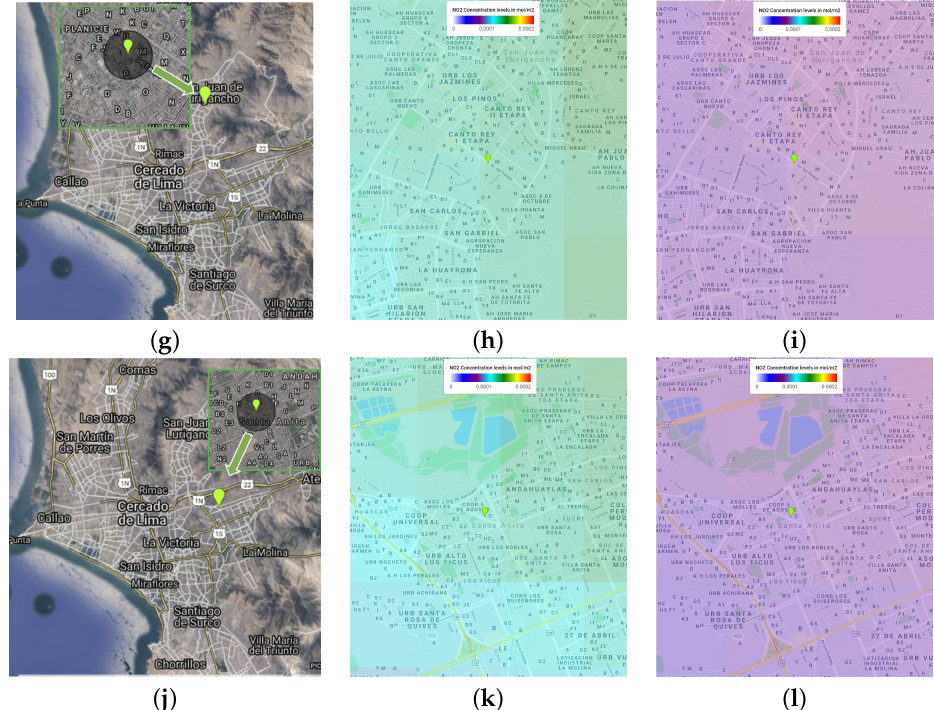
Figure 3. Example of spatial georeference for four areas of interest used to better understand the concentration levels of NO 2 around the region of interest. ( a ) Location of the sensor in Carabayllo and the visual comparison for ( b ) January–June 2019 and ( c ) January–June 2020. ( d ) Location of the sensor in the US embassy in Peru, and the visual comparison for ( e ) January–June 2019 and ( f ) January– June 2020. ( g ) Location of the sensor in ‘San Juan de Lurigancho’, and the visual comparison for ( h ) January–June 2019 and ( i ) January–June 2020. ( j ) Location of the sensor in ‘Santa Anita’ and the visual comparison for ( k ) January–June 2019 and ( l ) January–June 2020. In the second and third columns, the color bars indicate the NO 2 concentration levels on a scale of a minimum value of 0 and a maximum value of 0.0002 mol/m 2 as described in task five in Section 2.2. The locations of all the sensors are described in Table 1 and shown in Figure